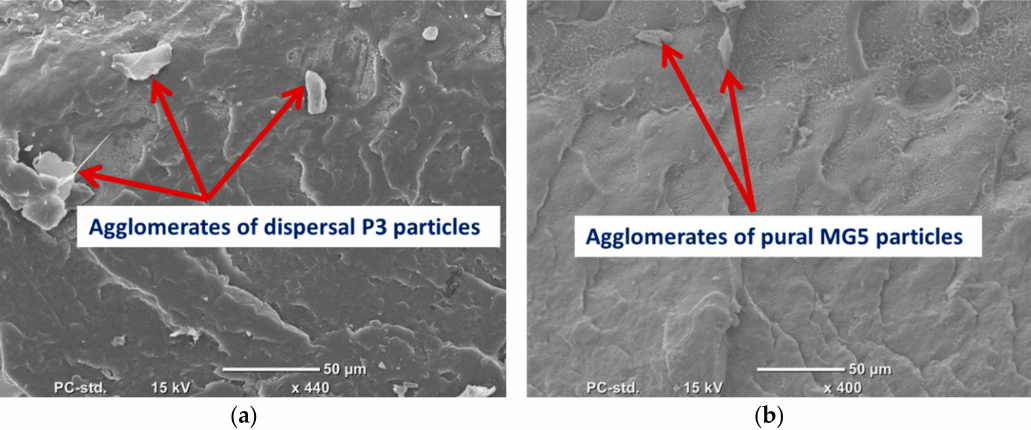
Figure 4. SEM micrographs of the cryo-fractured surfaces of ( a ) HDPE-5%P3 and ( b )